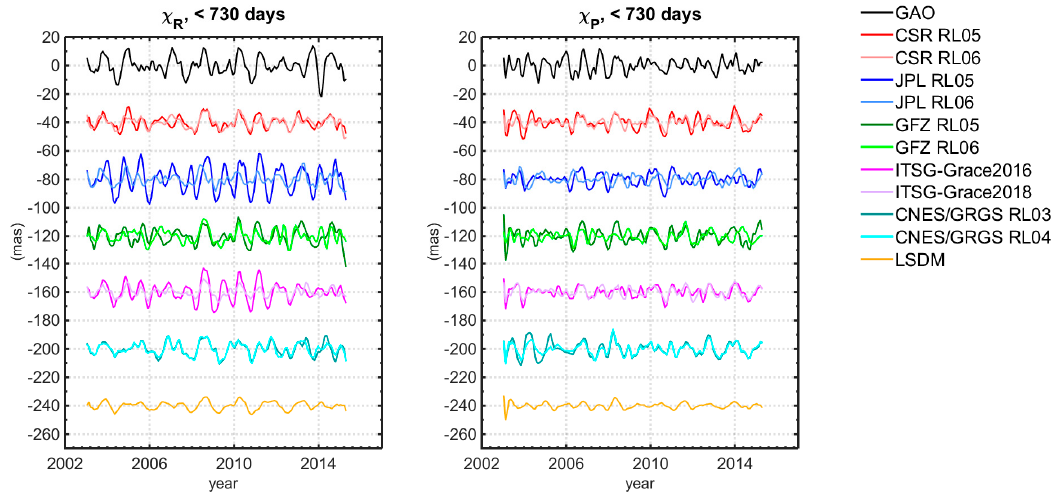
Figure 5. Retrograde and prograde parts ( χ R and χ P , respectively) of short-term ( < 730 days) non-seasonal variation in GAO, in HAM computed from different GRACE solutions, and HAM from the LSDM. The units are milliseconds of arc (mas). For better visibility, a bias was added to various HAM in order to shift them relative to each other.